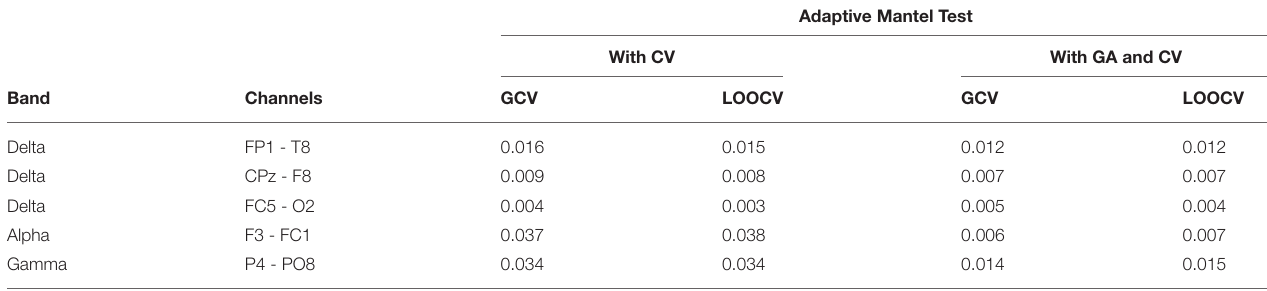
TABLE 4 | Comparison of the p -values using AdaMantCV and AdaMantGACV methods where heritability of EEG coherence is significantly greater than